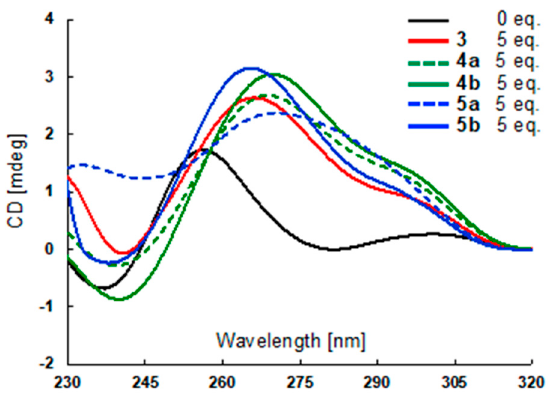
Figure 3. Circular Dichroism (CD) spectra of 3 , 4 and 5 in the presence of telomeric G4.